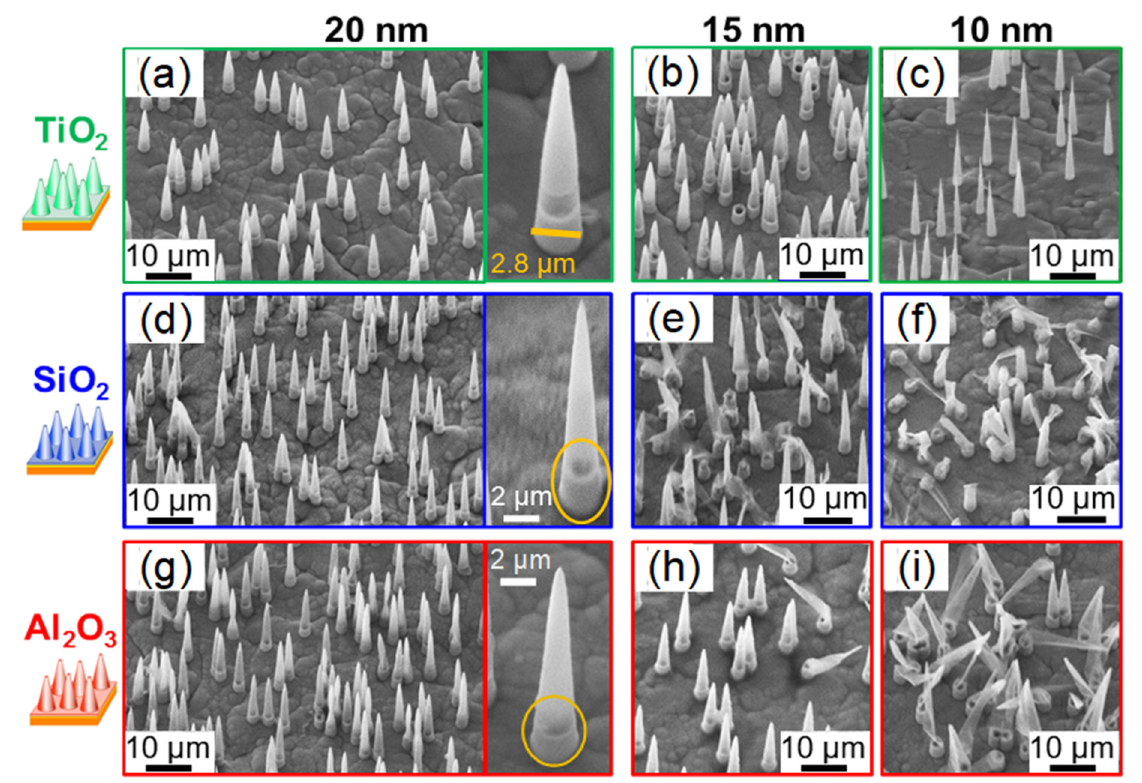
Figure 6. SEM images of TiO 2 ( a – c ), SiO 2 ( d – f ), and Al 2 O 3 ( g – i ) free-standing nanocones with wall thicknesses of ~20 nm, ~15 nm, and ~10 nm. The sputtered Au and electrodeposited Cu close to the cone base are visible at a higher magnification (single cones in a , d , g ). The images are recorded under a tilting angle of 20°.